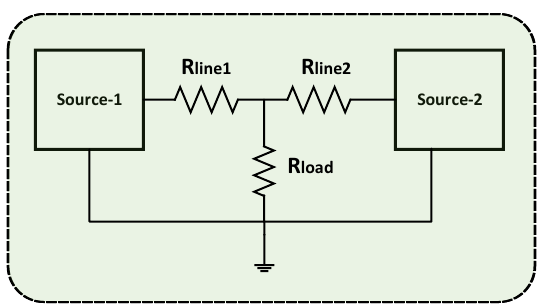
Figure 2. DC microgrid model consisting of two sources feeding a single load along with its equiva- lent Thevenin